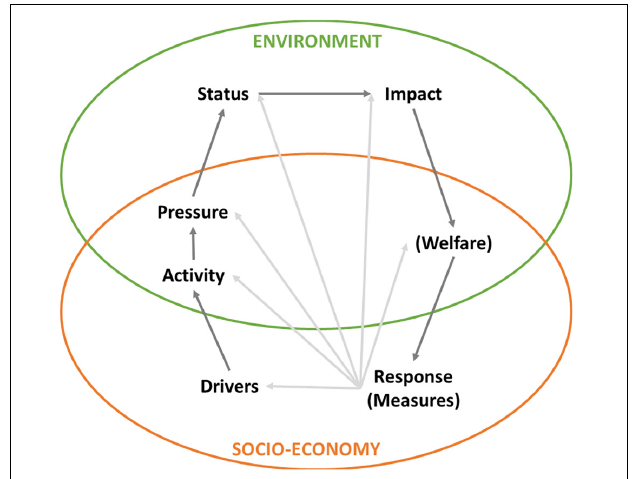
FIGURE 1 | DAPSI(W)R(M) framework inside environment and socio-economy spheres. “Activity,” “Pressure,” and “Welfare” are part of both socio-economy and environment spheres, as complex links between environmental and social elements are needed to carry out activities, and to obtain welfare (understood as human well-being); furthermore, activities generate pressures that are placed on the ecosystems. The environmental sphere contains “Status” and “Impacts,” as both allude to environmental elements. The socio-economy sphere contains the “Drivers” and “Response (Measures). “Response” in the form of management “Measures” can be adopted to change or remove “Drivers,” “Activities,” “Pressures,” “Status,” “Impacts,” and/or “Welfare” (these links are represented in light gray to indicate that they are optional, as not all of them have to happen together).